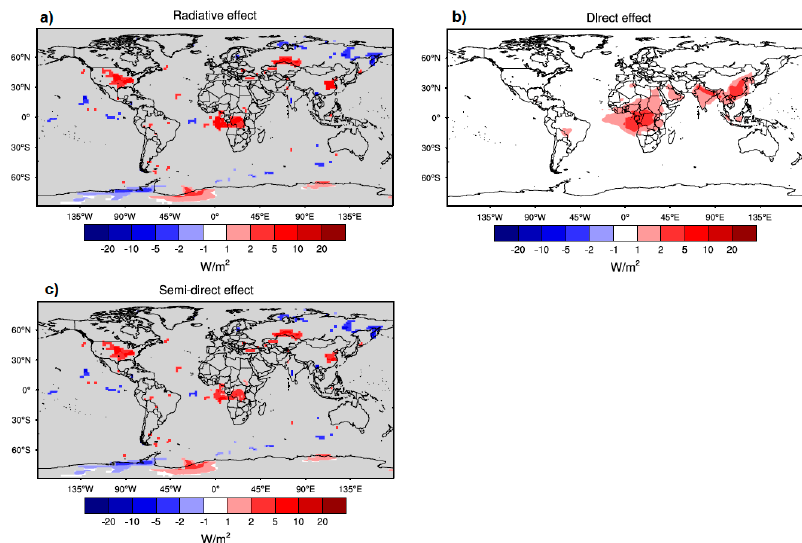
Figure 6. ( a ) Direct radiative effect (DRE) of BC aerosol calculated from TOA radiative fluxes as difference of experiments noDUST–noABS; ( b ) instantaneous radiative effect (IDR) calculated as ( a ) but excluding changes in cloud cover by BC forcing via double call to the radiation scheme in the model, and ( c ) semi-direct effect (SDE) at the top of atmosphere in Wm − 2 calculated as DRE-IDR. ( d ): as ( c ), for the GFAS simulation. Grey areas indicate regions where the results are not statistically significant at 95%